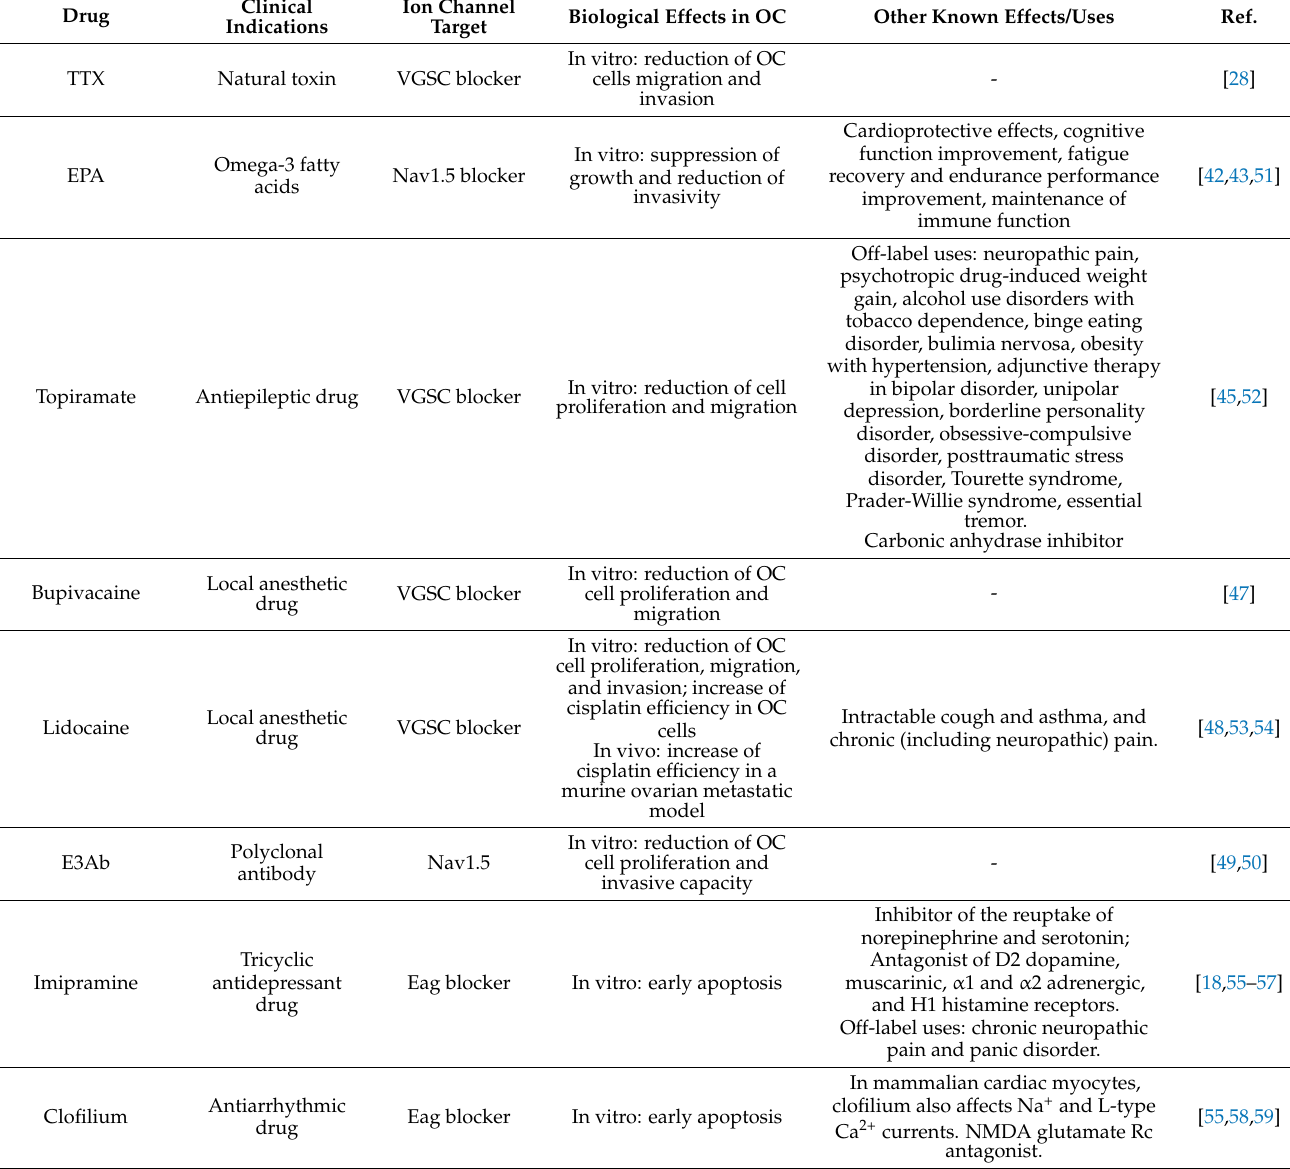
Table 1. Ion channels blockers and openers tested in OC and their biological